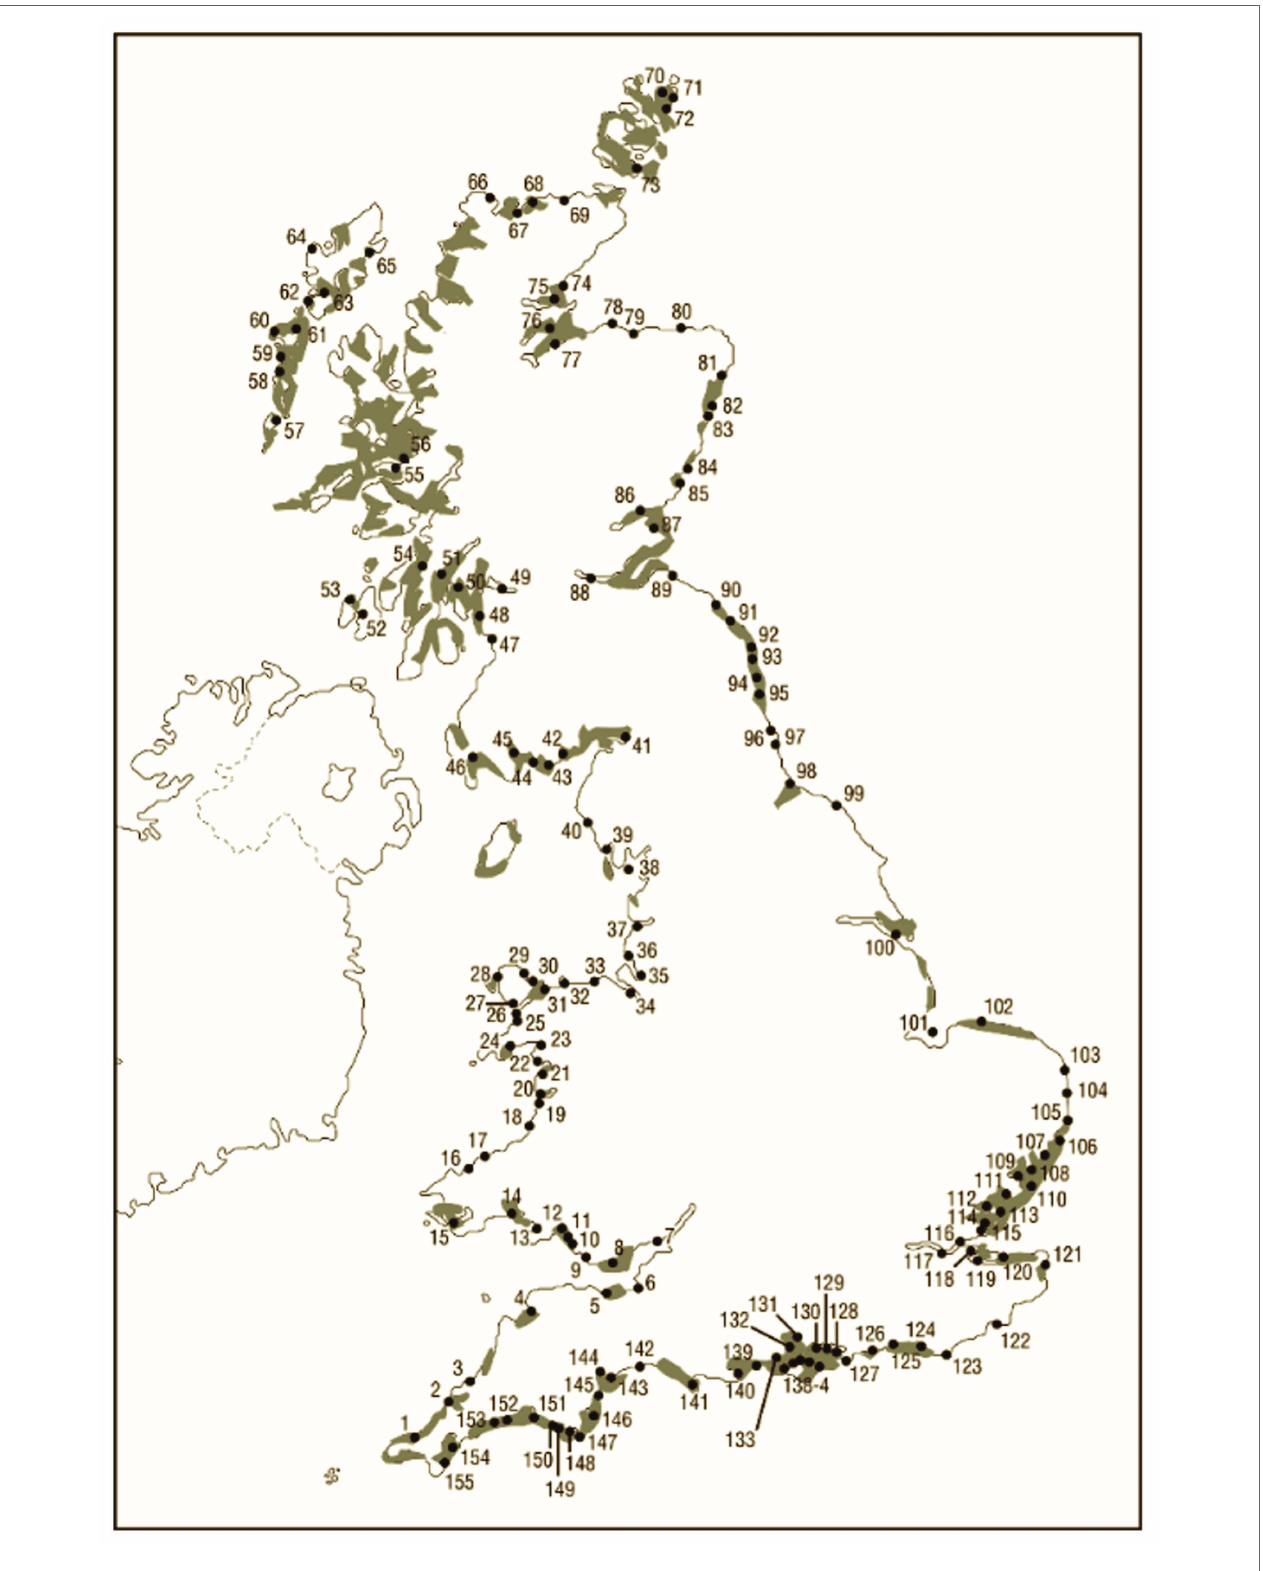
FIGURE 1 | Butcher’s 1930s estimate of seagrass area cover (shaded; Butcher, 1934) and numbers referring to estuaries identified by Nature Conservancy Council (Davidson et al., 1991; image created by UCL drawing